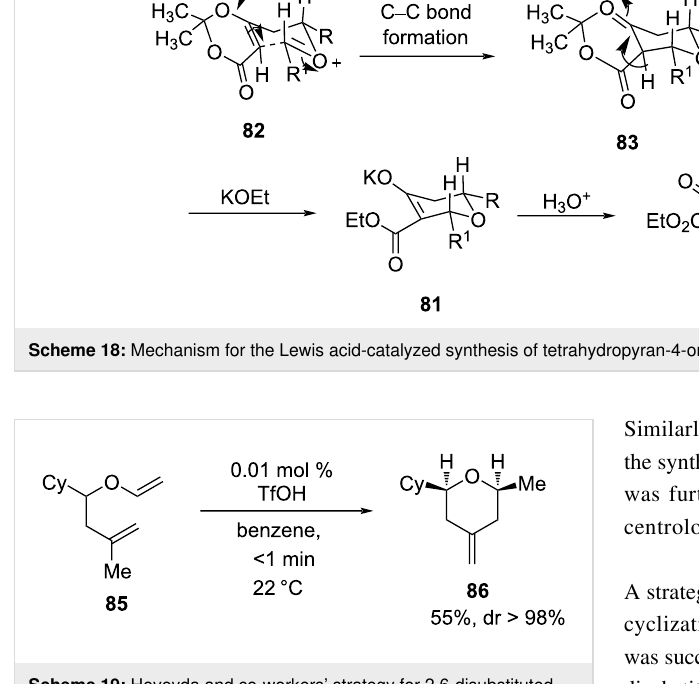
Scheme 19: Hoveyda and co-workers’ strategy for 2,6-disubstituted